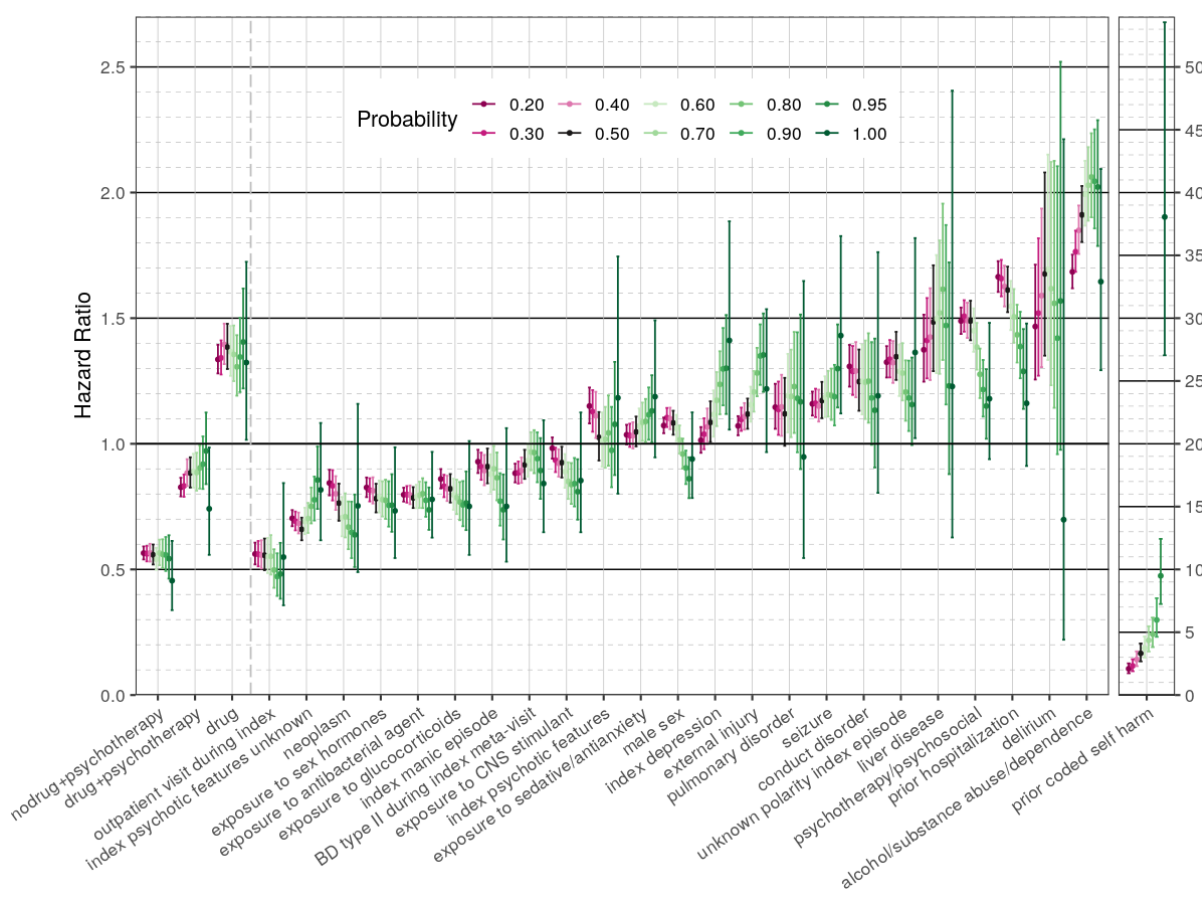
Figure 5. Sensitivity analysis for the “low-risk” and “high-risk” covariates in the second regression model comparing pharmacotherapy (as a single exposure category) and psychotherapy for the risk of self-harm. The X-axis shows 27 covariates and the respective 20%-100% self-harm probability thresholds chosen to impute the outcome. The Y-axis shows the respective hazard ratios (HRs) (colored dots) and CIs (colored lines). Varied intensity magenta is used to represent the range of 20%-40% self-harm probability thresholds, black is used to represent the 50% threshold of the main model, and varied intensity green is used to represent the 60%-100% probability threshold used. The covariate “prior coded self-harm” is separated out with a different HR scale in the far right, since the HR values were extremely high at the 100% (coded) probability threshold. BD: bipolar disorder; CNS: central nervous system; Drug: any of the bipolar disorder drugs of